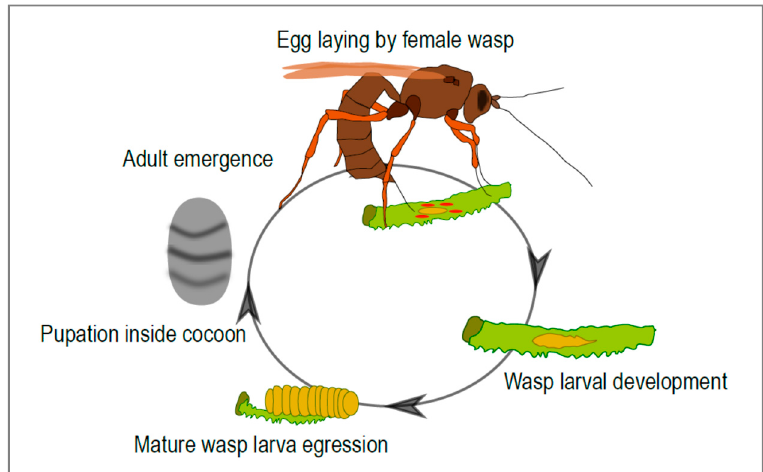
Figure 1. Life cycle of an ichneumonid parasitoid wasp associated with mutualistic viruses. The adult female wasp injects virus particles along with the eggs during parasitization. The progeny develops within the body of the parasitized insect. At the end of larval development, the mature larva egresses from the host and spins a cocoon where pupation takes place. A free-living adult then emerges from the cocoon.